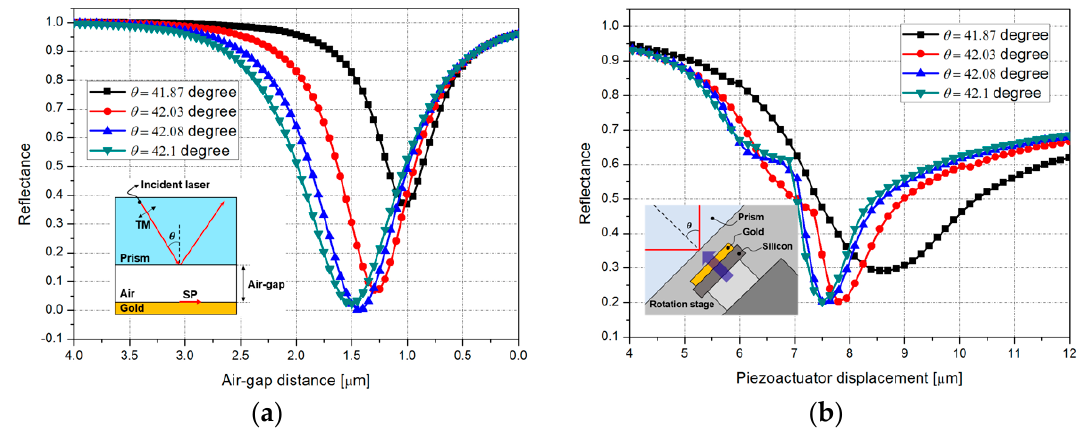
Figure 11. SPR characteristics with air-gap variation: ( a ) simulation result; ( b ) measurement result. Table 2. Sensor characteristics for Kretschmann and Otto configurations.